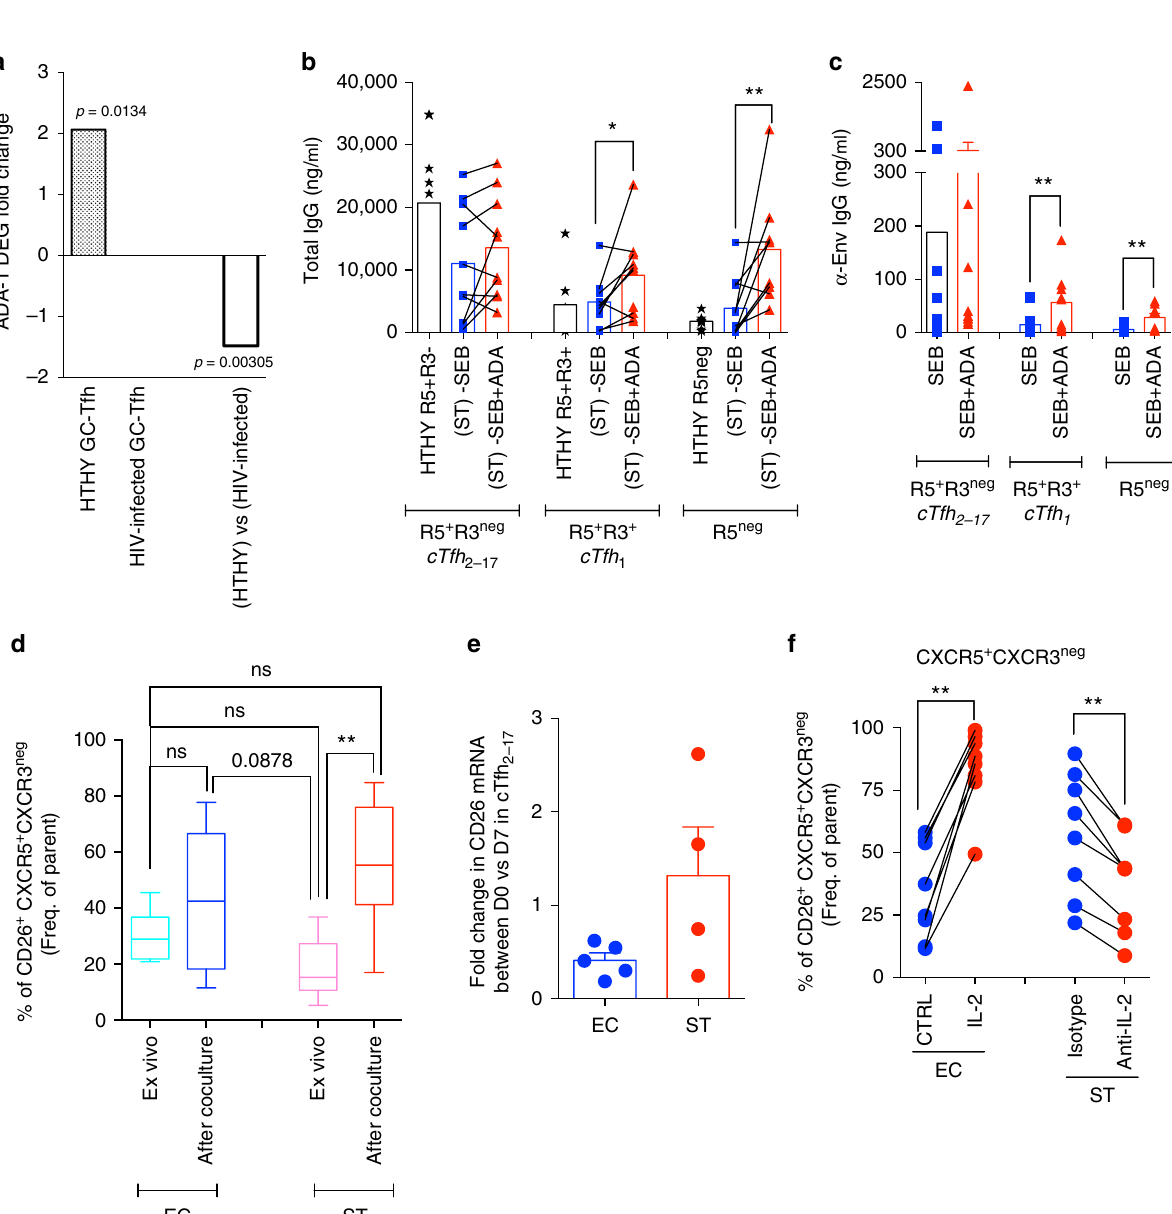
Fig. 7 ADA/CD26 axis is impaired during HIV infection. a Fold change of ADA-1 gene expression in divided (CFSE lo ) GC-Tfh after 5 days of co-culture with GC-B cells ( n = 4 healthy (HTHY) individuals; n = 6 HIV-infected individuals; Mean ± SEM). b Production of IgG in the supernatants from each ST-cTfh and ST-non-cTfh co-culture after supplementation with ADA-1 ( n = 6 per group, in two-independent experiments). (Wilcoxon, paired, two-tailed non- parametric t -test; * p < 0.05, ** p < 0.01; Mean± SEM). Healthy (HTHY) co-culture have been reported as control. c Production of α -Env-IgG in the supernatants from each ST-cTfh and ST-non-cTfh co-culture after supplementation with ADA-1 ( n = 9 per group, in twoindependent experiments). (Wilcoxon, paired, two-tailed non-parametric t -test; * p < 0.05, ** p < 0.01; Mean ± SEM). d Frequency of ex vivo and 7-day co-culture of CXCR5 + CXCR3 neg CD26 + T cells subsets in EC and ST individuals ( n = 8 – 11, three-independent experiments). (ANOVA, non-paired, two-tailed non-parametric t -test; * p < 0.05, ** p < 0.01). Whiskers represent Min to Max. e Fold change in the relative expression of CD26 mRNA, as assessed by real-time PCR analysis with respect to measurements at day 0. Results from fi ve EC and four ST subjects are shown. Each dot represents the average of two biological replicates with four to six experimental replicates each. Bars represent Mean ± SEM. f Frequency of CXCR5 + CXCR3 neg CD26 + T cells subsets in co- cultures of EC-cTfh in presence of IL-2 (left panel: n = 8 per group, two-independent experiments) and from ST-cTfh in presence of anti-IL-2 antibody (right panel: n = 7 per group, two-independent experiments). (Wilcoxon, paired, two-tailed non-parametric t -test; ** p < 0.01; Mean ±